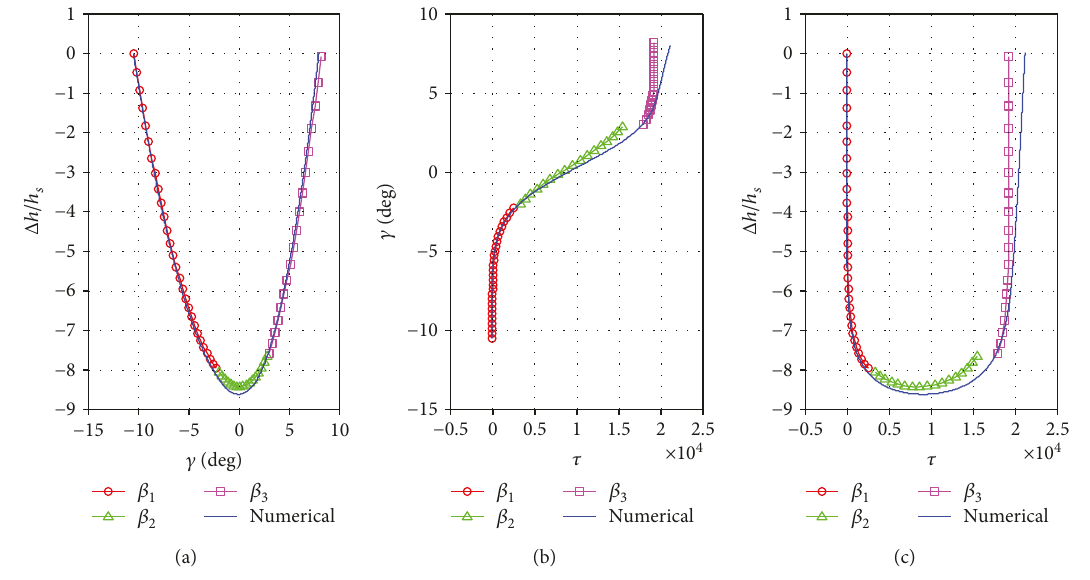
Figure 5: Analytical solution for double ballistic coe ffi cient Table 1: Probe parameters for Monte Carlo simulation [6, 20].